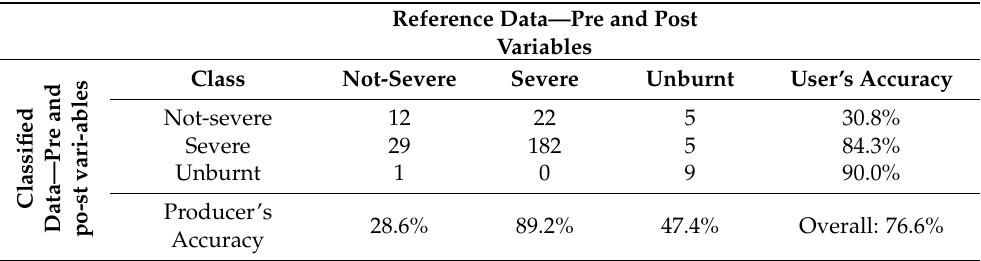
Table 11. Confusion matrix for image-only stream describing severity of forest segments.